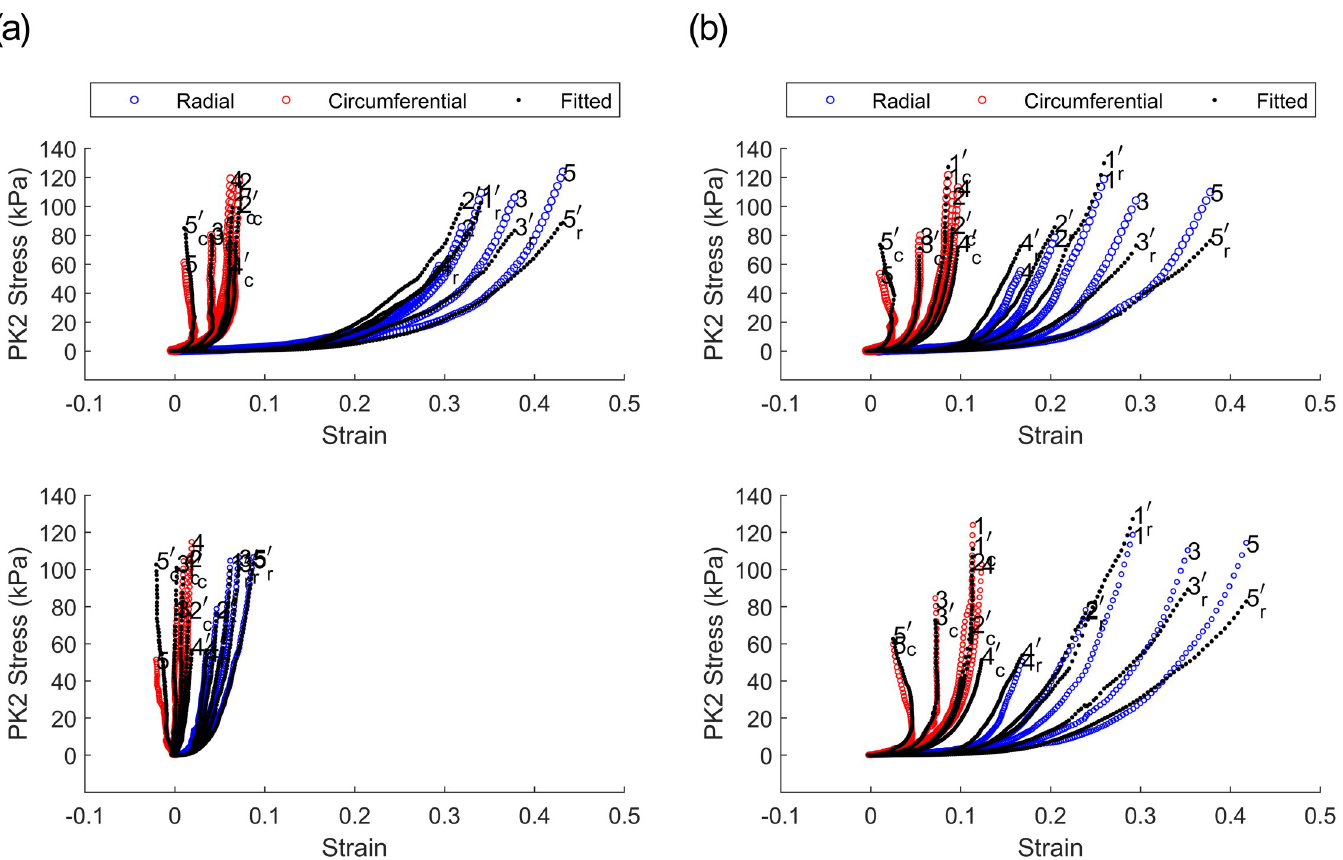
Fig 5. Data fitting to a typical heart in both groups utilizing the Fung-type model for a) elastase-treated and b) control group. Fitting for data prior to treatment (top) compared to after receiving treatment application (bottom). Single number represents the protocol while the number with the added prime represents the optimized fit result.